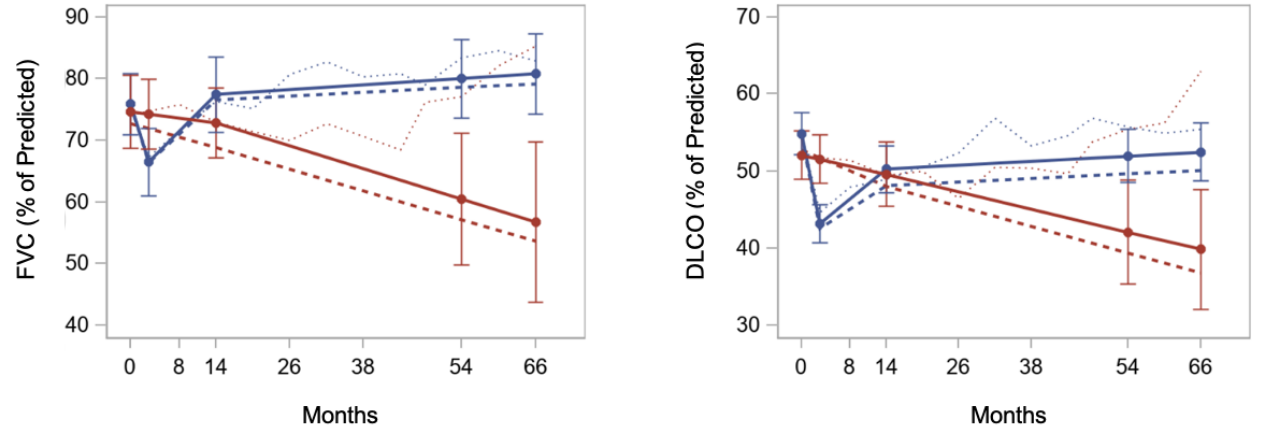
Figure 3. Longitudinal trends over 66 months from randomization for Forced Vital Capacity (FVC: left) and diffusing lung capacity for carbon monoxide (DLCO: right) in patients undergoing autologous hematopoietic cell transplantation (autoHCT: blue line) vs. conventional therapy (12 monthly infusions of cyclophosphamide: red line) [68]. AutoHCT patients had slightly improved FVC at 54 and 66 months compared to baseline, whereas the FVC worsened in the conventionally treated patients. Similar trends were observed for DLCO. Reproduced with permission from Wiley Global Publishing, Arthritis Care and Research , published by Wiley Publishing Global, 2021.